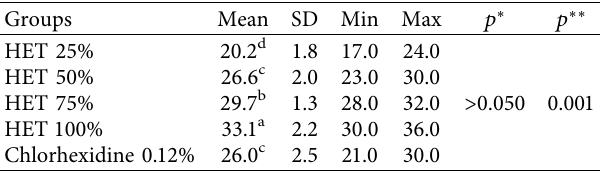
Table 1: Inhibition halo of HET against the S. mutans strain.